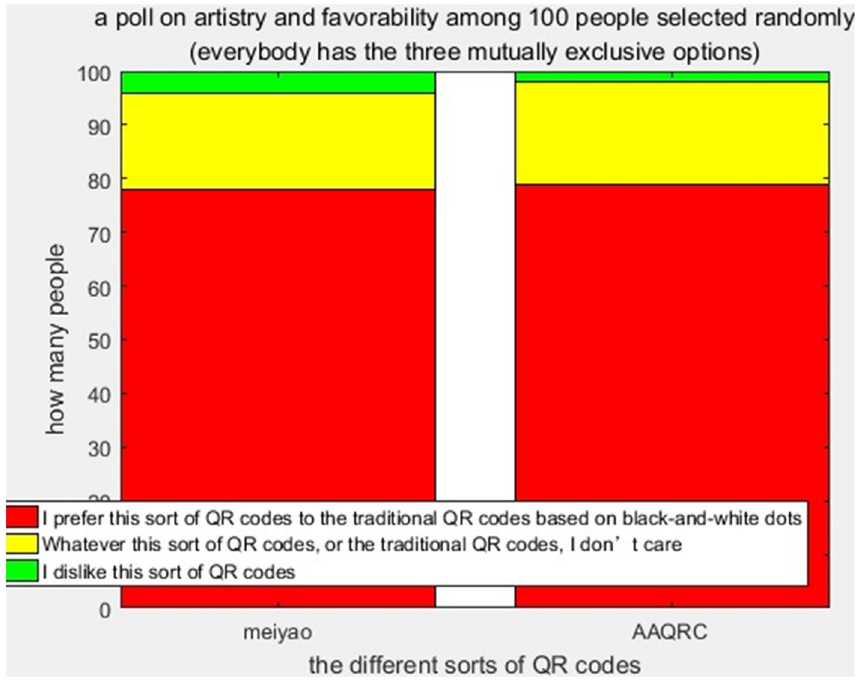
Figure 9. A poll on artistry and favorability among 100 persons selected randomly.